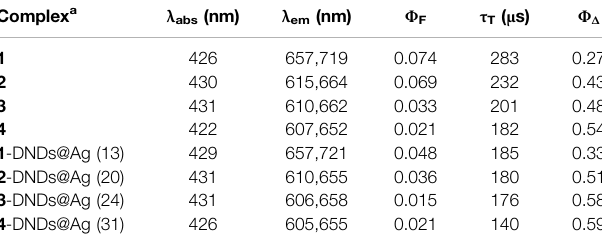
TABLE 1 | Photophysicochemical data of synthesized complexes in DMSO.